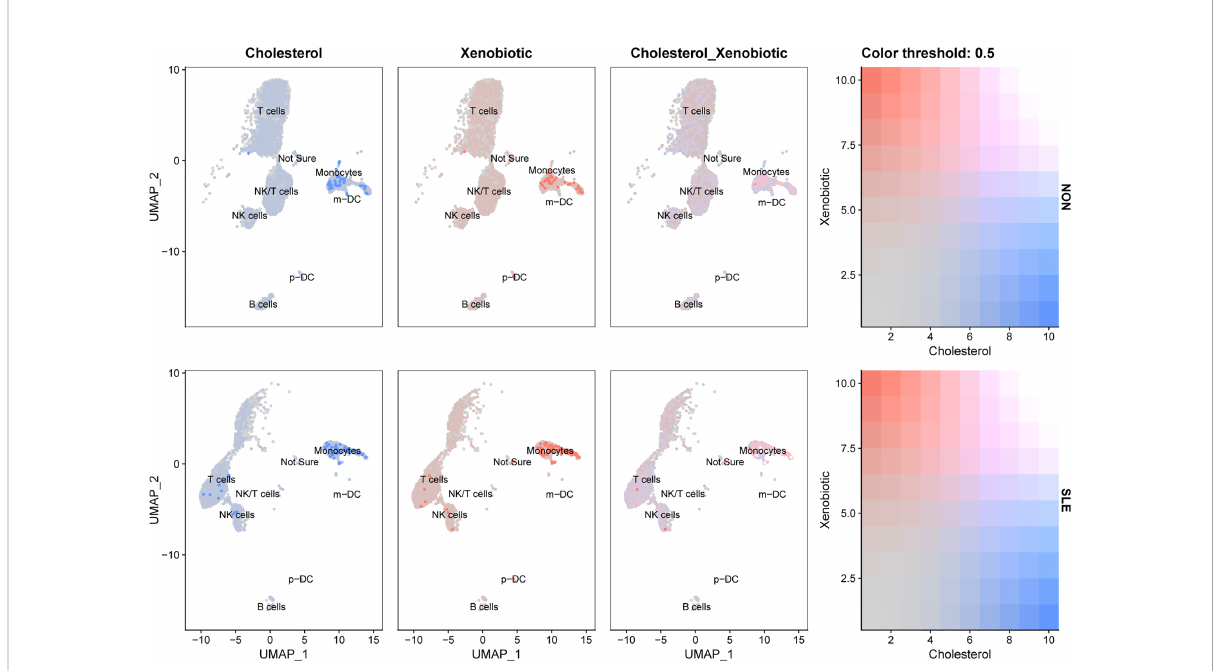
FIGURE 13 UMAP visualization of cholesterol homeostasis and xenobiotic metabolism scores in controls and SLE patients in GSE135779. Blue dots indicated cholesterol homeostasis, and pink dots indicated xenobiotic